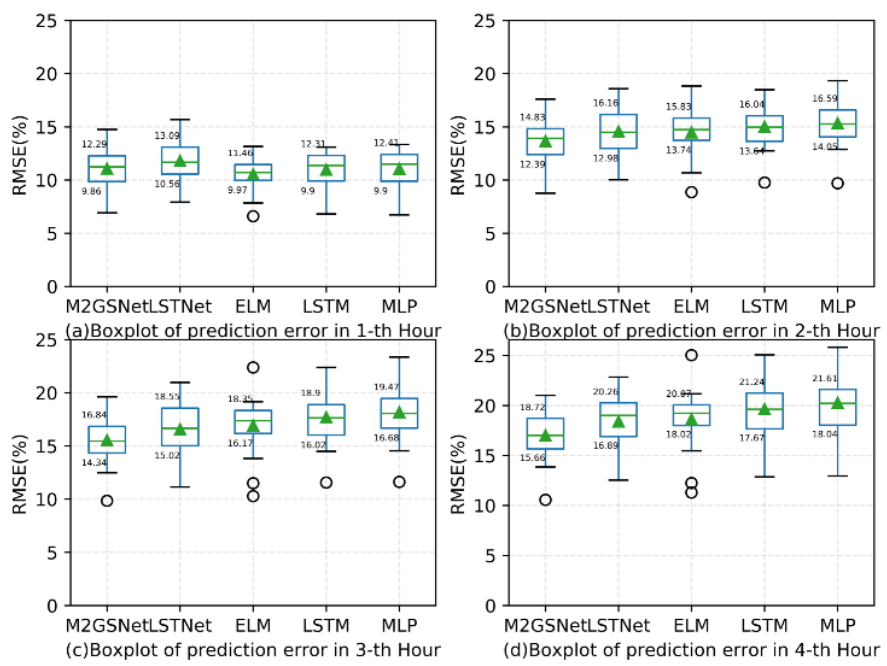
Figure 7. Boxplot of prediction results for wind farms.